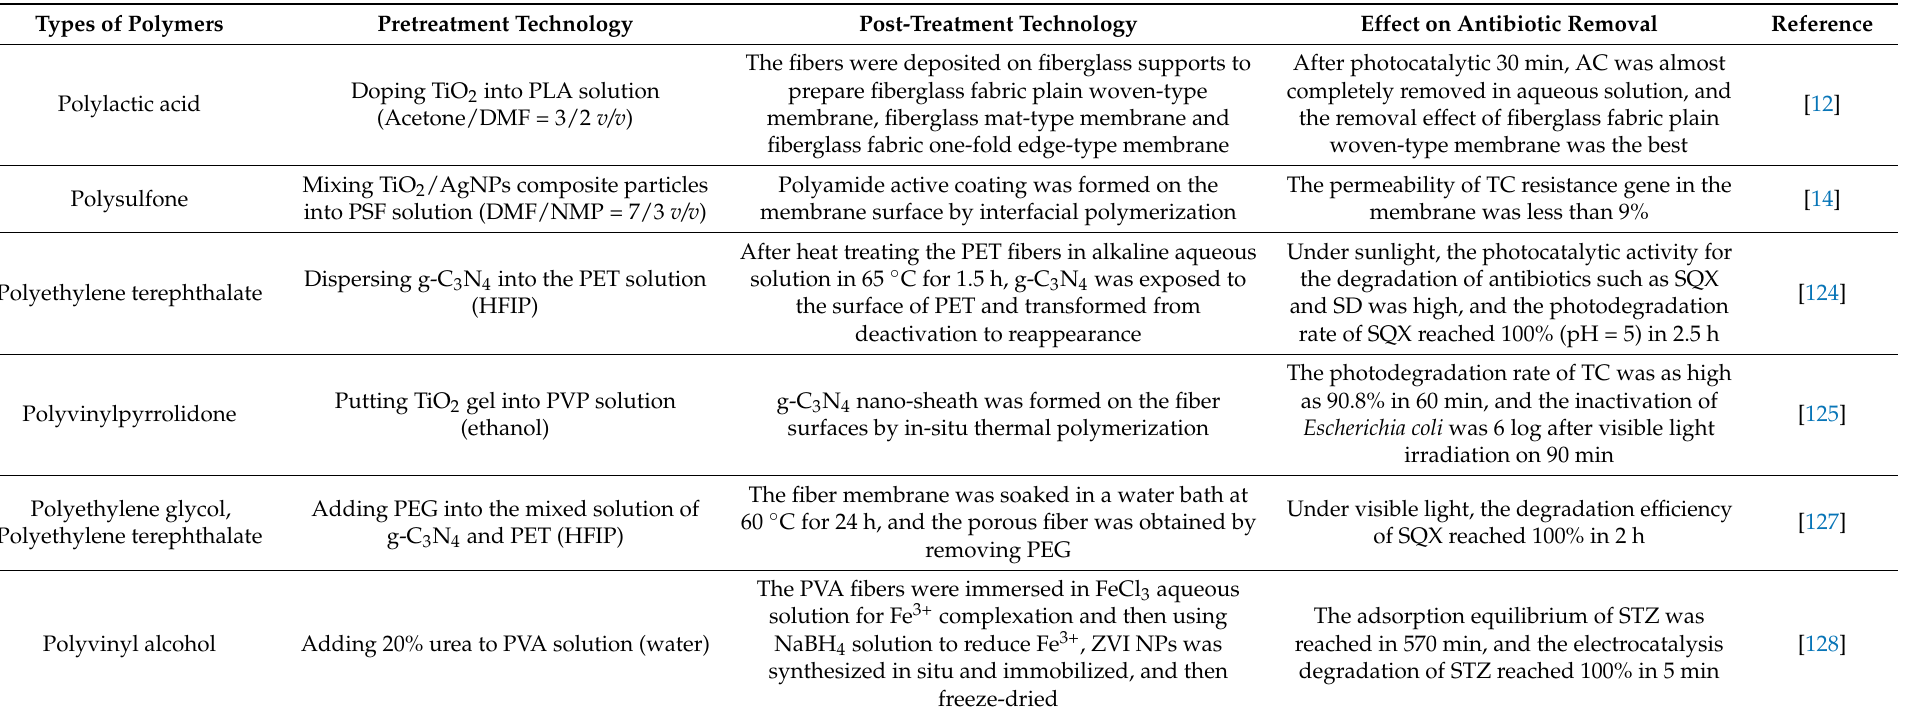
Table 3. Preparation technology and parameters of partially electrospun functional fiber membranes for antibiotic